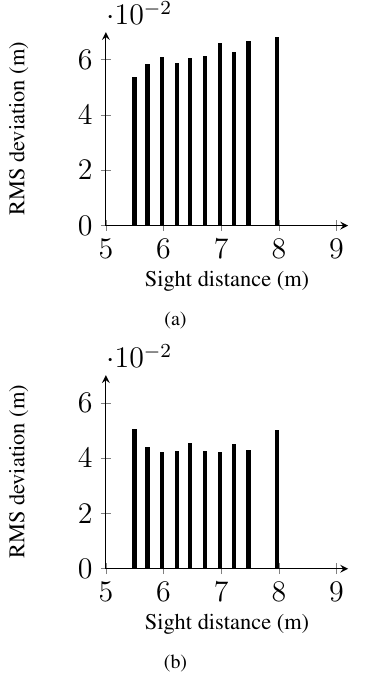
Figure 14. RMS deviation (accuracy) at different observation dis- tances (a) between the depth maps obtained by Mesa-Imaging software and the Faro plane, (b) between the corrected depths ob- tained with our distance calibration and the FARO plane